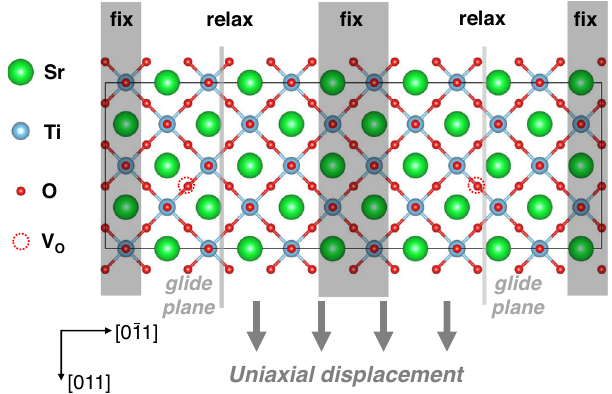
Fig. 1 | Model for the calculations of local mis fi t energy. The SrTiO 3 supercell contains120atomsandincludestwoglideplanes,markedbypinklines,tomaintain the periodic condition. All the atoms excluding those in the dark regions are allowed to fully relax in all directions. The un- fi lled dashed line circles mark the positions in which the oxygen vacancies V O are selected when calculating the de fi cient